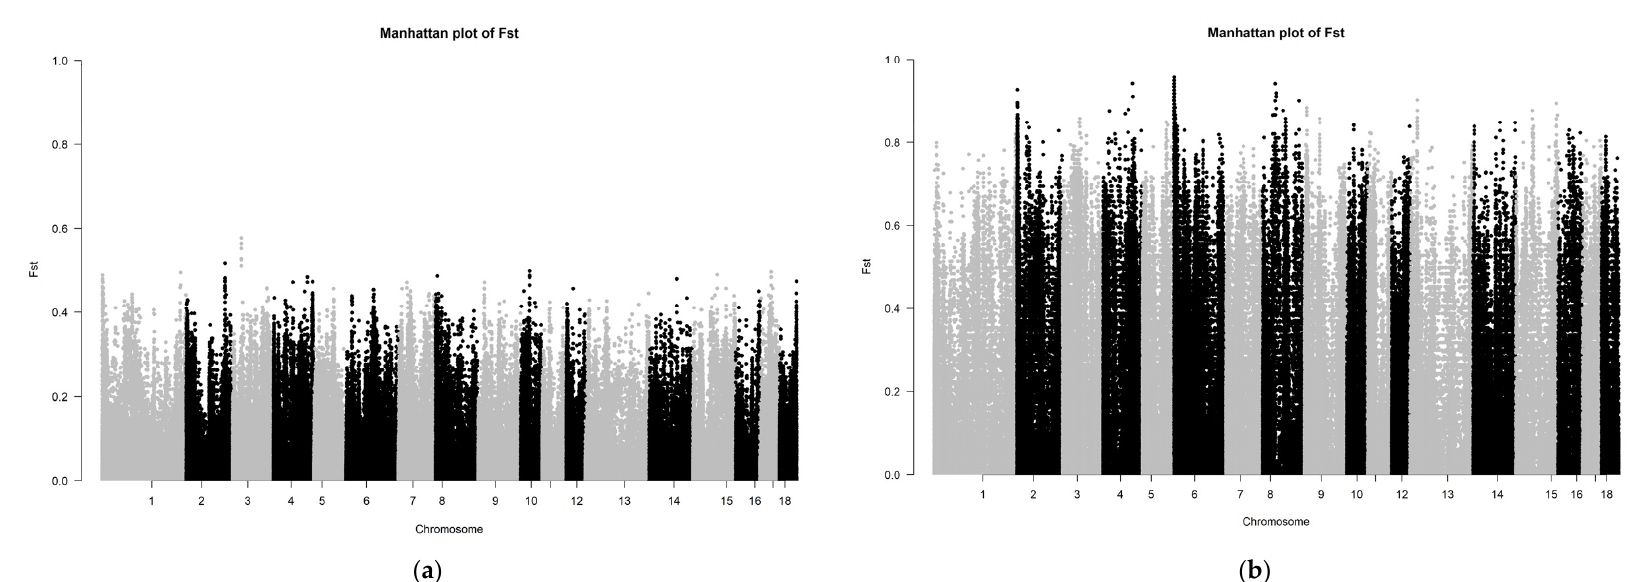
Figure 5. ( a,b ) Manhattan plot based on F st of LU–LW pigs and LU–YY pigs by GGRS. Figure 5. ( a , b ) Manhattan plot based on F